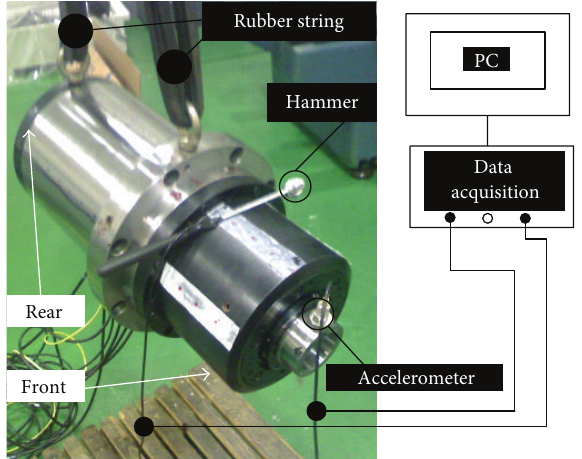
Figure 10: Scene of impact test based on LMS Test Lab.